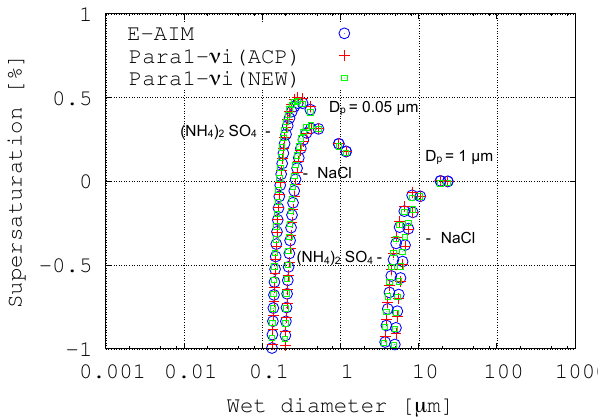
Figure B2. Wet particle diameter, D wet , as a function of super- saturation for pure NaCl and (NH 4 ) 2 SO 4 aerosols with different dry diameters, i.e. D s = 0 . 05 and D s = 1 [ µm ] as shown in Fig. 5 of M2012. S is defined as S = (s − 1 ) × 100 [ % ] ; s is the satura- tion = fractional